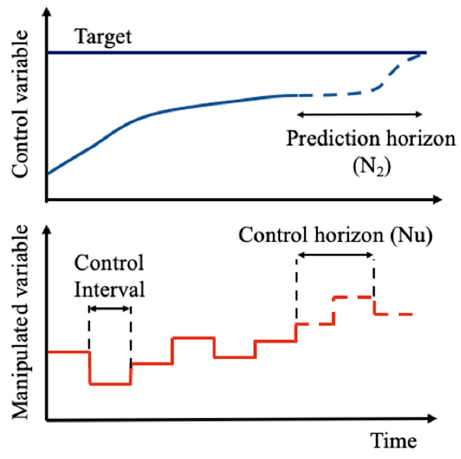
Figure 4. Illustration of the MPC.